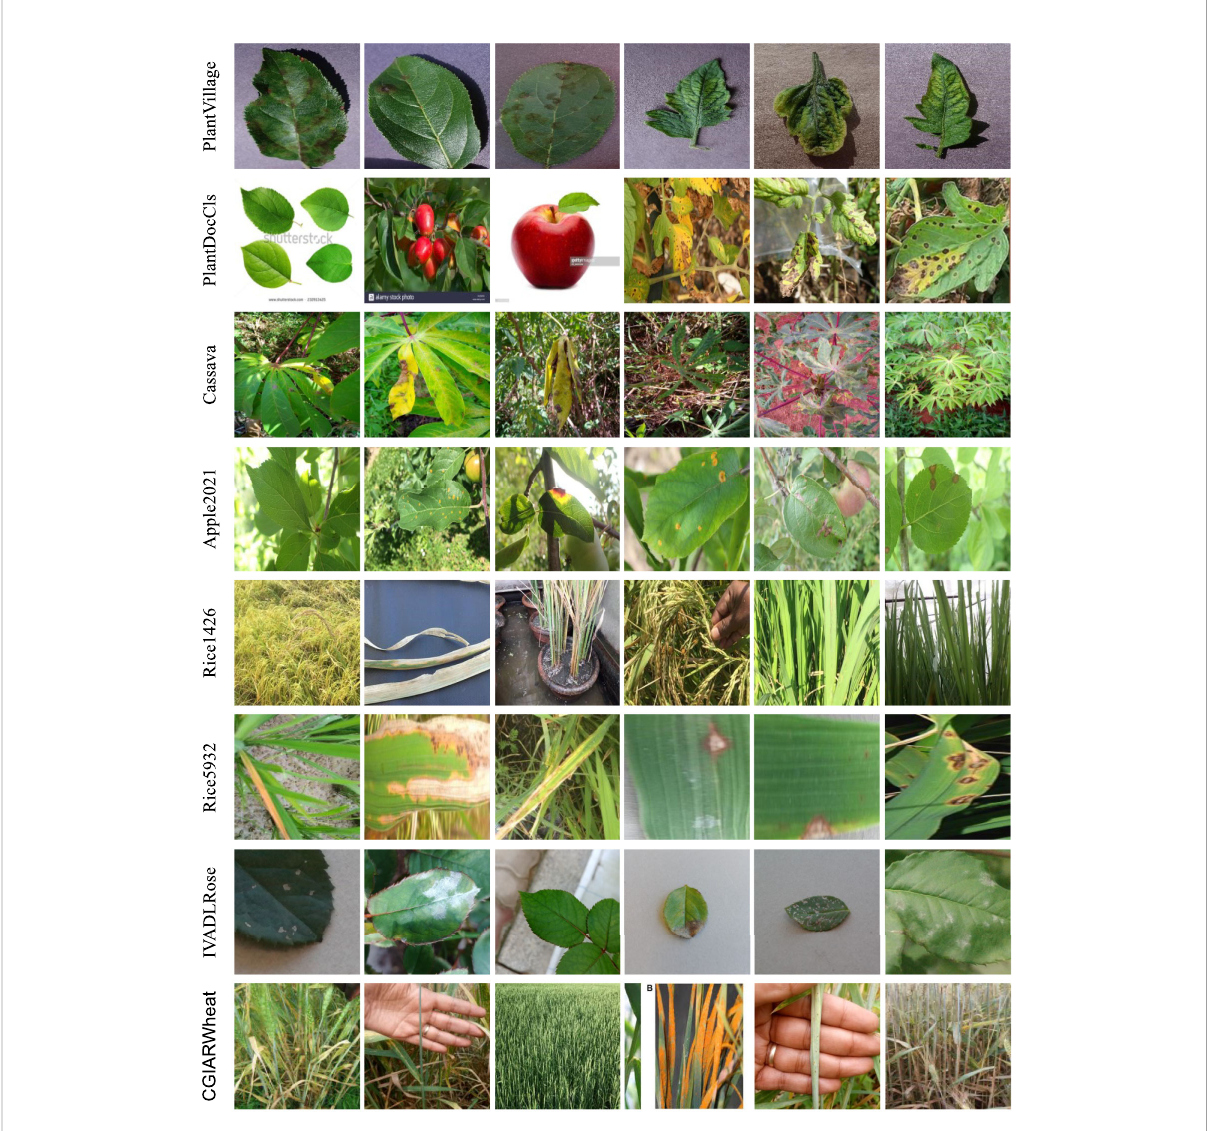
FIGURE 2 Image examples from different datasets. We recognize that there are image variations [40], such as background, the shape of leaves, illumination, and